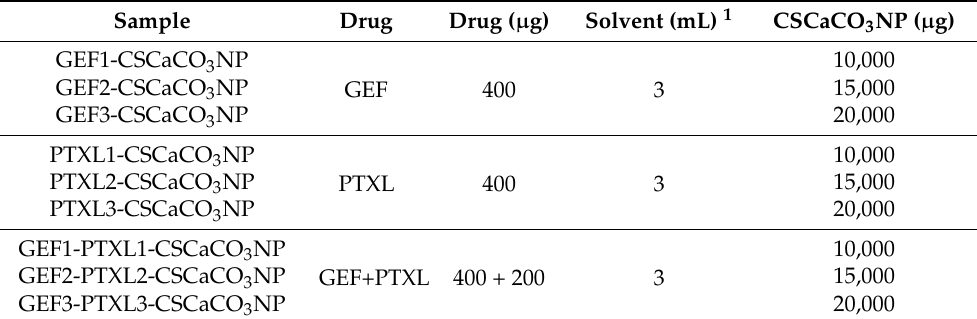
Table 1. Experimental design for synthesizing drug-loaded CSCaCO 3